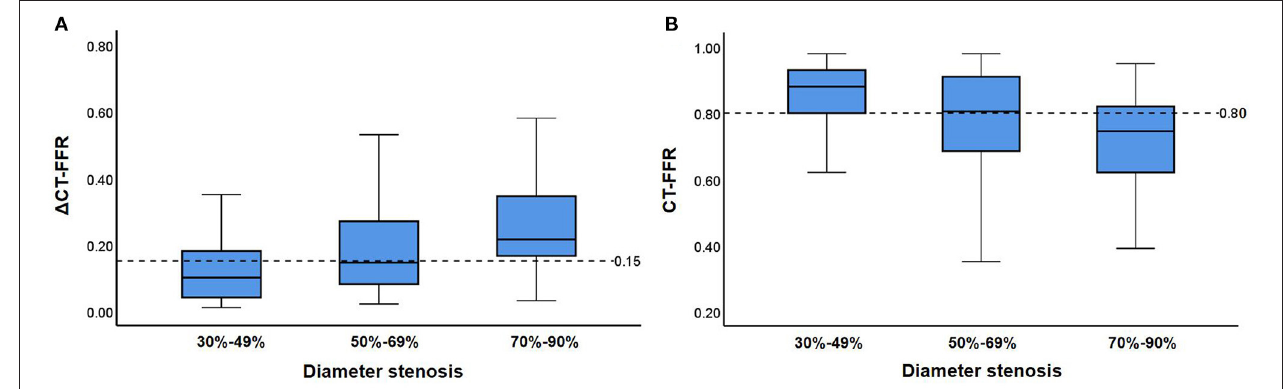
FIGURE 4 | Relationship between CT-FFR and stenosis on CCTA. (A,B) show distributions of 1 CT-FFR (A) , CT-FFR (B) in each group with 30–49, 50–69, and 70–90% diameter stenosis on CCTA. Medians, quartiles, and ranges of 1 CT-FFR as well as CT-FFR are shown in the box plot. Cut-off values of 1 CT-FFR as well as CT-FFR are displayed as dashed lines. CT-FFR, computed tomography-derived fractional flow reserve.